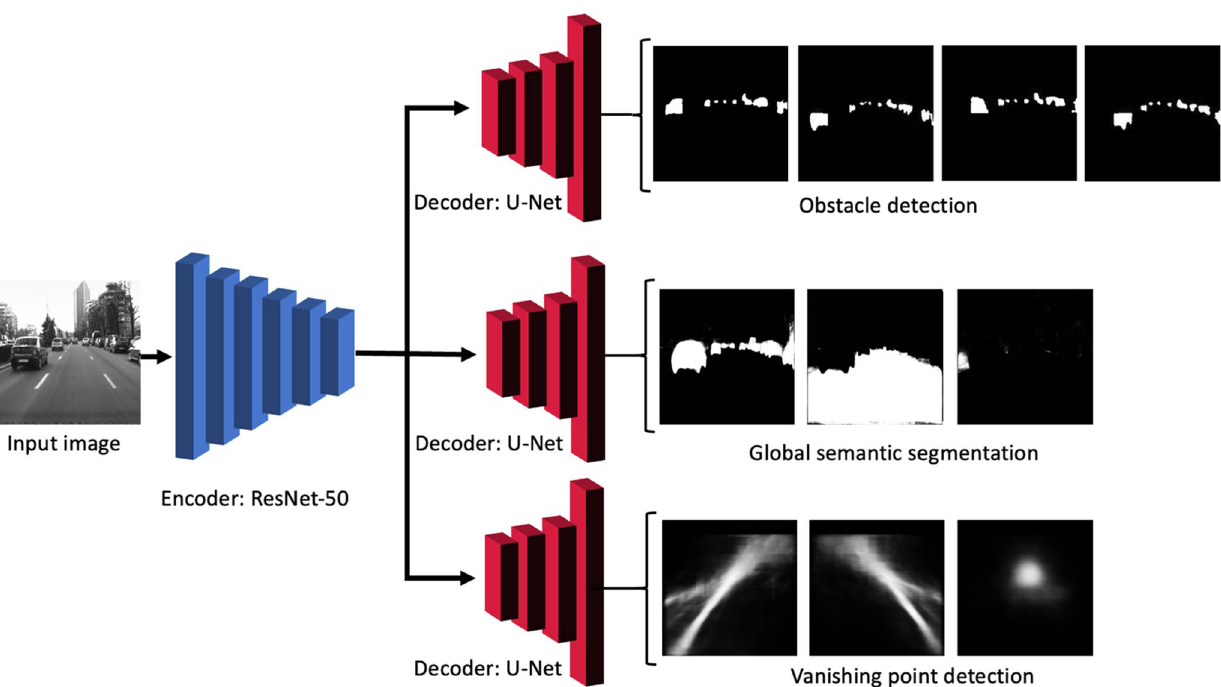
Figure 1. The multiple-output neural network architecture.